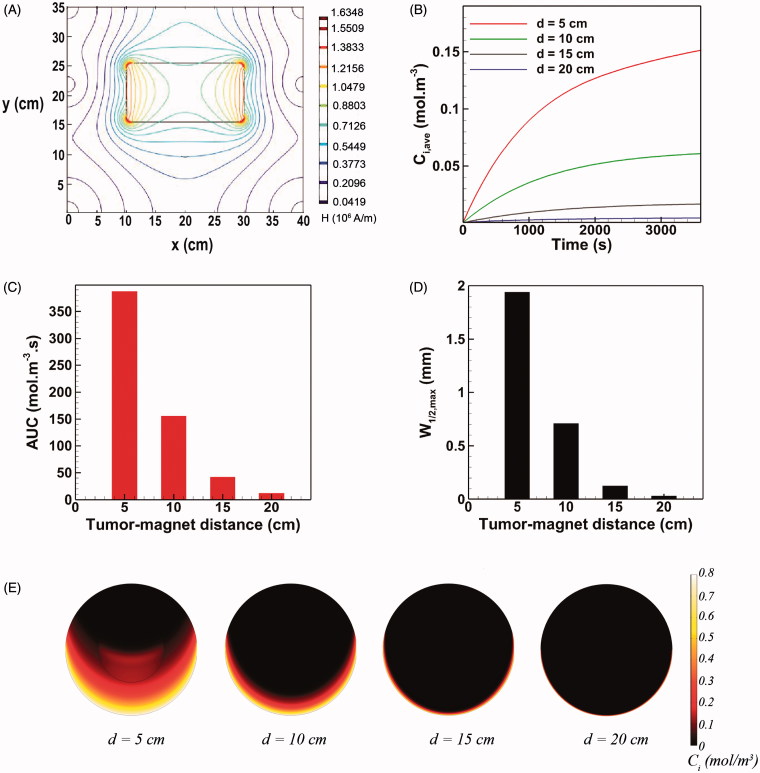
The effect of tumor-magnet distance on magnetically assisted IP drug delivery. (A) The gradients of magnetic field reduce rapidly by increasing the distance of tumor from the magnet. (B–D) The MDT performance parameters Ci,ave, AUC, and W1/2,max strongly deteriorate as the tumor-magnet distance increases. (E) Interstitial retarding forces dominate magnetic forces for d > 10 cm and the drug penetration region remains limited to the lower half rim of the tumor.